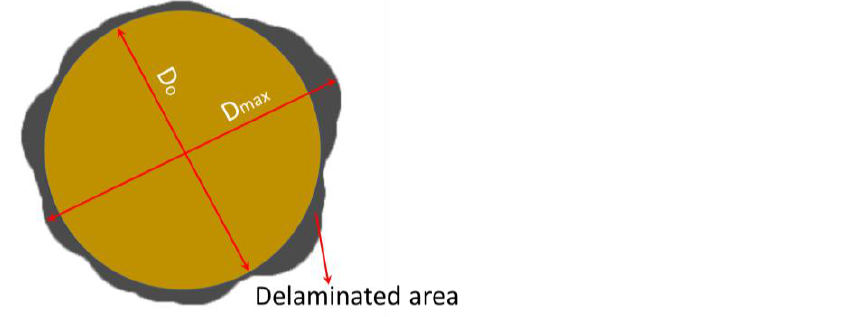
Figure 2. A schematic diagram of the measurement of the delamination factor.